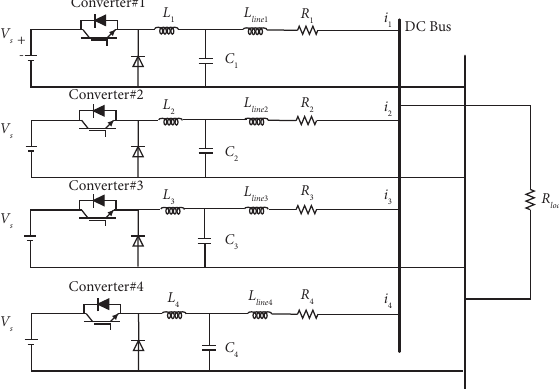
Figure 3: Te simulink structure of the DC